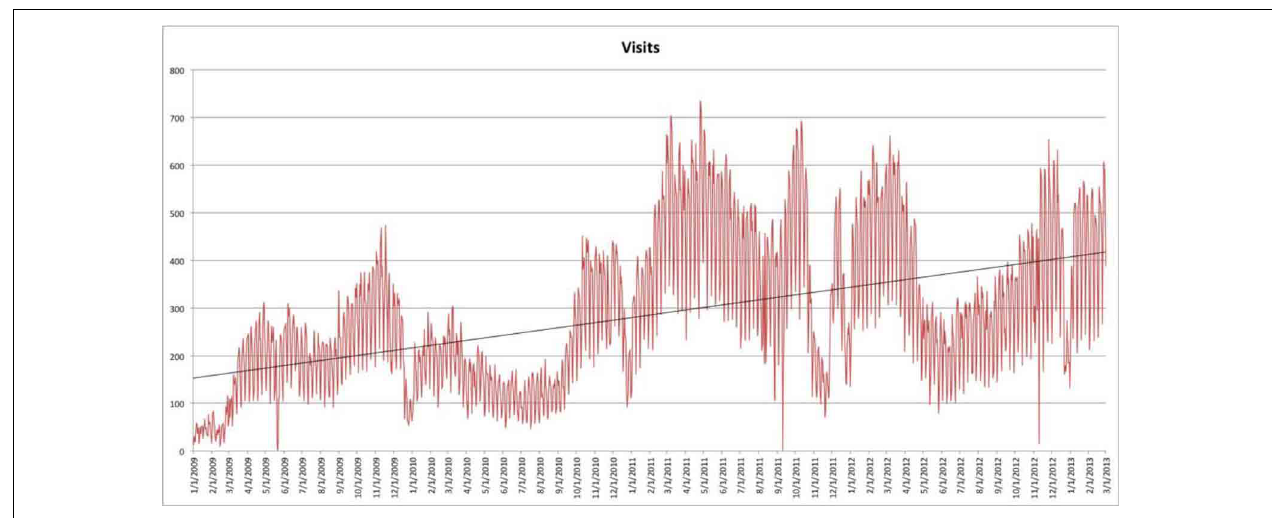
FIGURE 5 | A graph of visits to NeuroLex.org over time since December 2008. Hits in 2010 were depressed by modifications in the presentation of metadata for search engines. This was corrected at the end of 2010, which